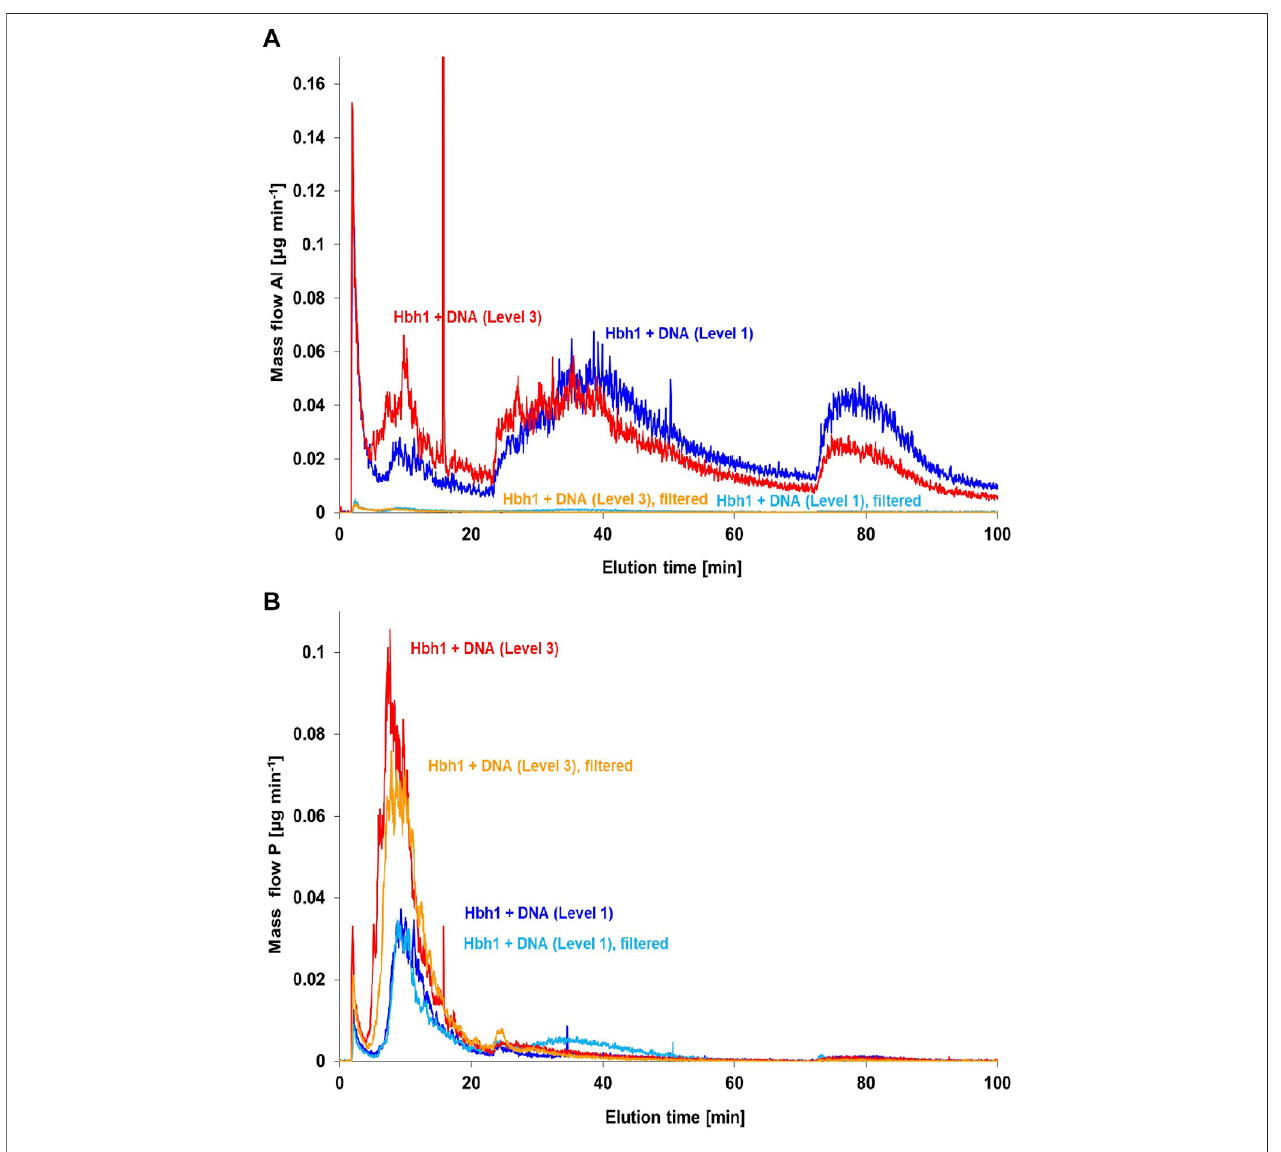
FIGURE 8 | Post-channel fi ltration for the separation of DNA – clay adducts from free DNA in CT-DNA-spiked water samples at two concentration levels (1) and (3) monitoring Al (A) and P (B) .